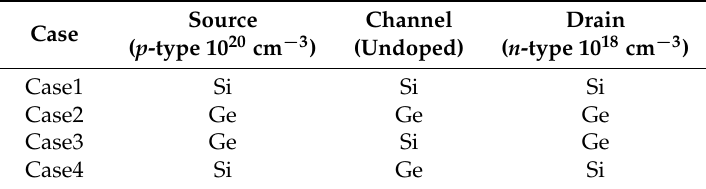
Figure 1. Basic schematic of tunnel field-effect transistor (TFET) structure in this study. In order to analyze the performance and the characteristics of the TFETs with two-dimensional device simulation, this kind of double gate structure is used representing the cross-section of the horizontal fin field-effect transistor (FinFET) structure. Table 1. Material combinations of the devices analyzed in this study.